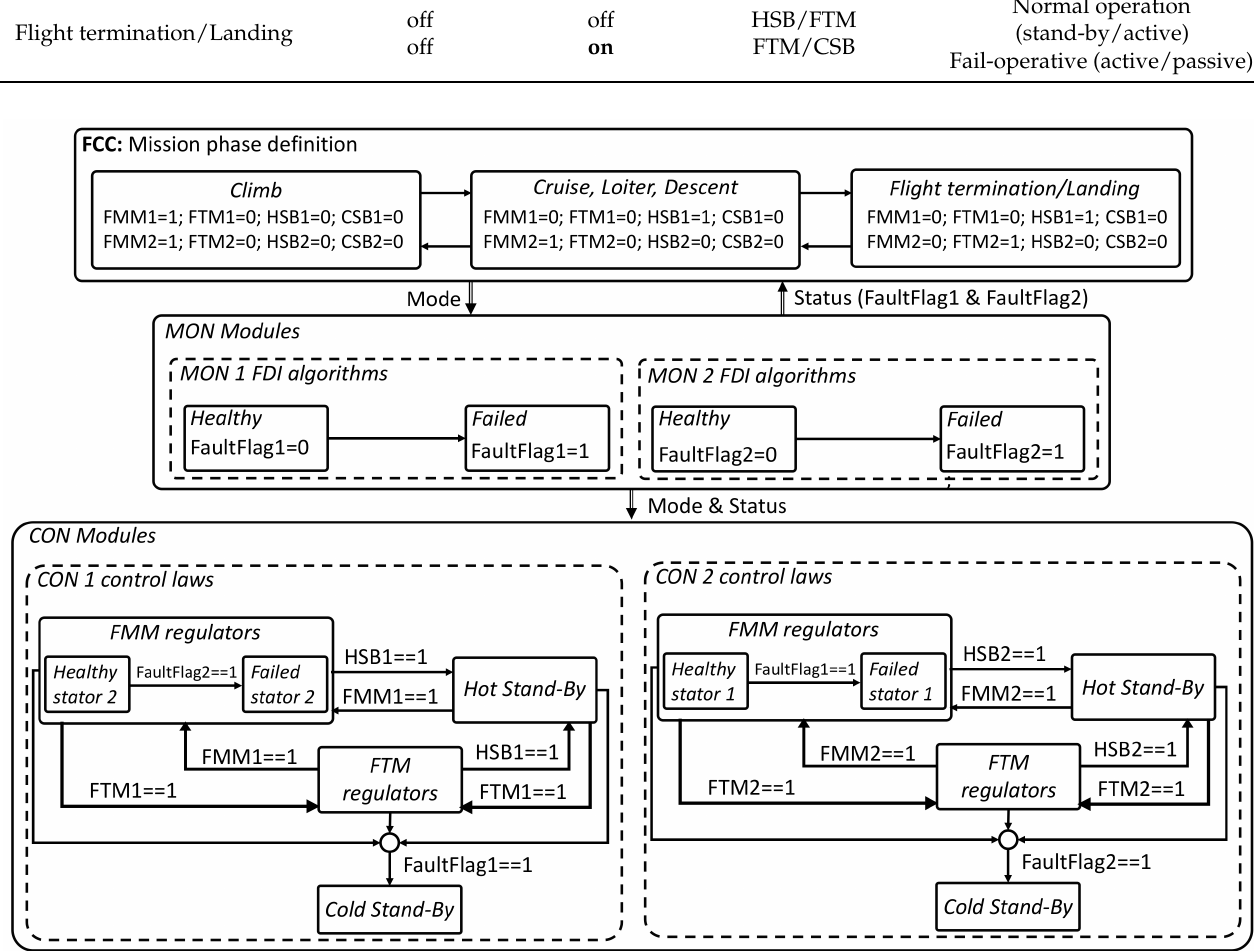
Figure 3. Flow chart defining FEPS operation